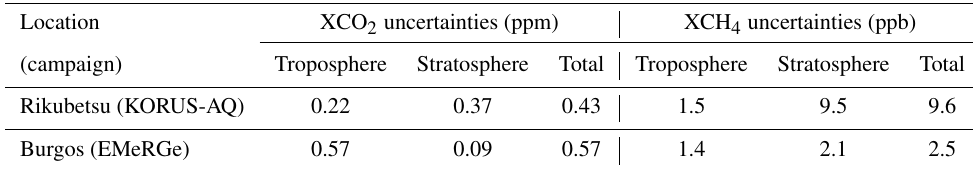
Table 2. Uncertainties in aircraft XCO 2 and XCH 4